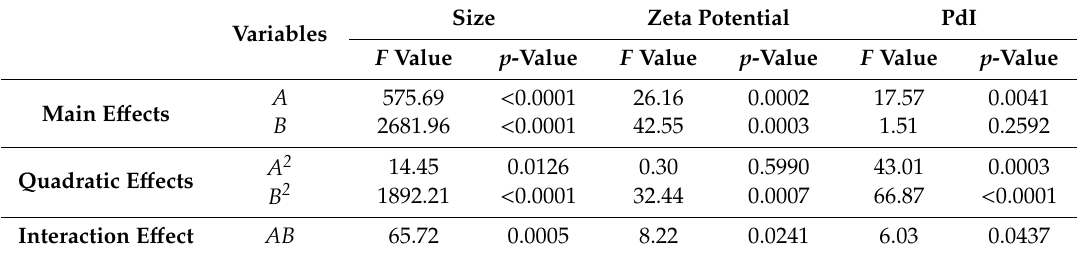
Table 3. ANOVA of regression coe ffi cient of the fitted quadratic equation for